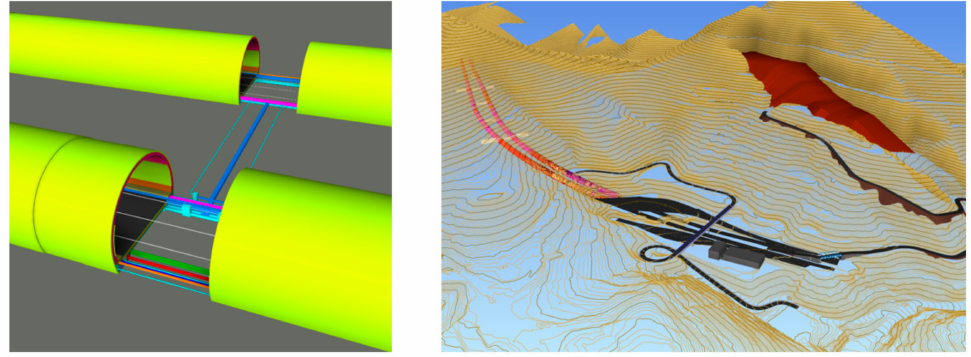
Figure 5. Initial model and updated model of the Arnotegi tunnel.